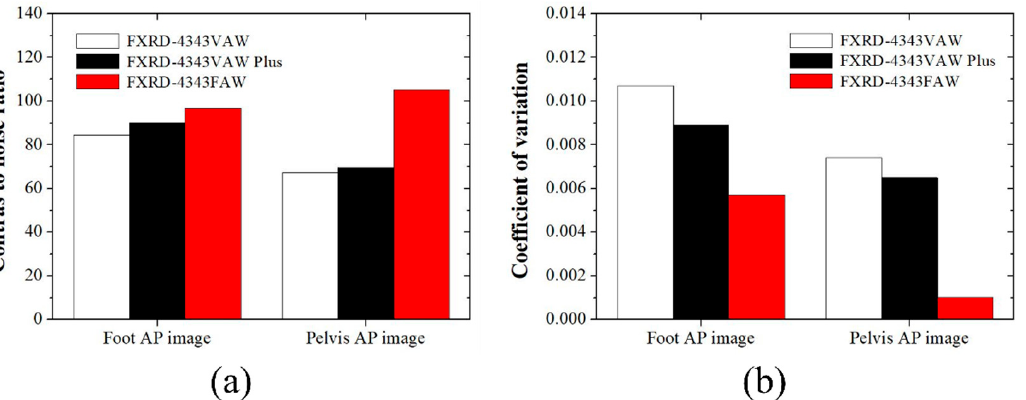
Figure 4. ( a ) CNR and ( b ) COV obtained using the three detectors in relation to the ROI shown in Figure 3.